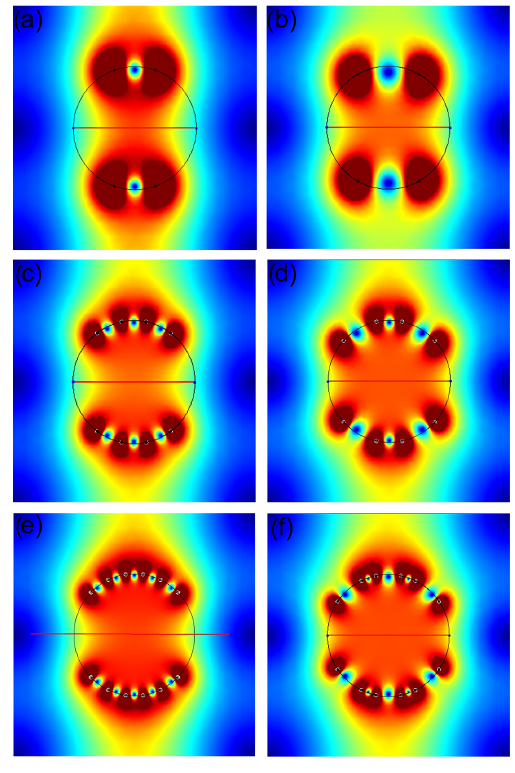
Figure 7. Magnetic field homogeneity of the Everett–Bolinger coil: (a) , (c) and (e) , respectively, for two, four and six turns. The SHS coil: (b) , (d) and (f) , respectively, for two, four and six turns.